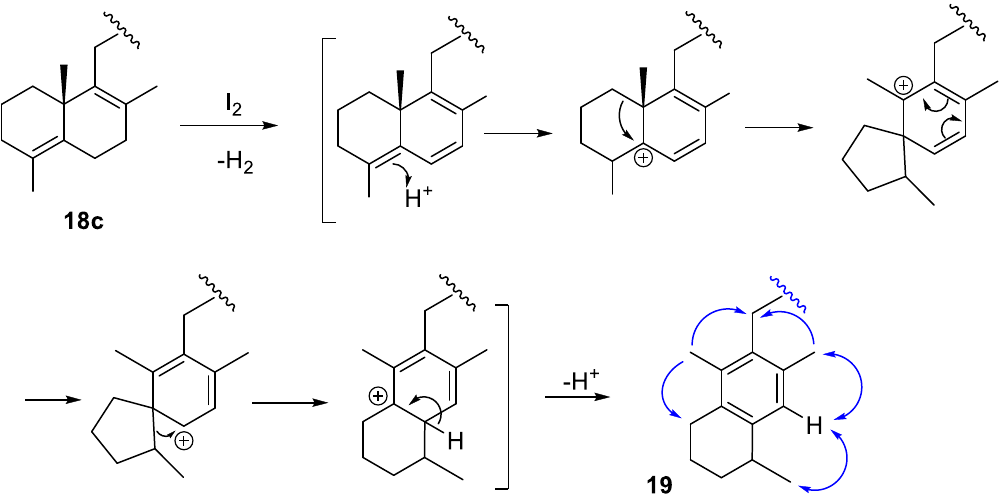
Scheme 7. Proposed mechanism for the formation of compound 19 . The blue arrows represent the experimentally ob- served NOEs.